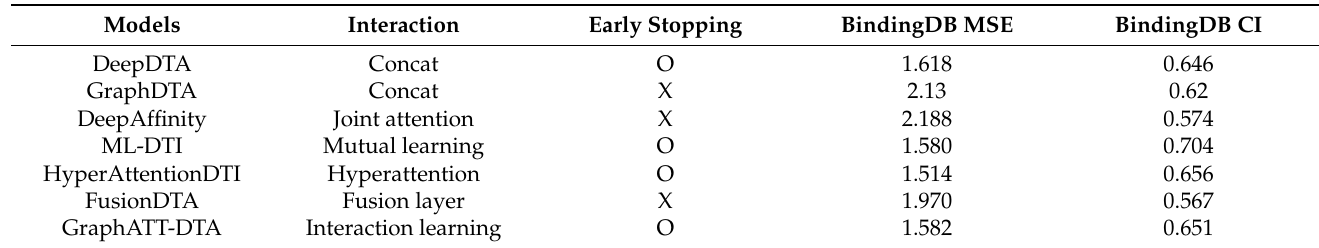
Table 7. Prediction performance over the BindingDB external test set of GraphATT-DTA and baseline